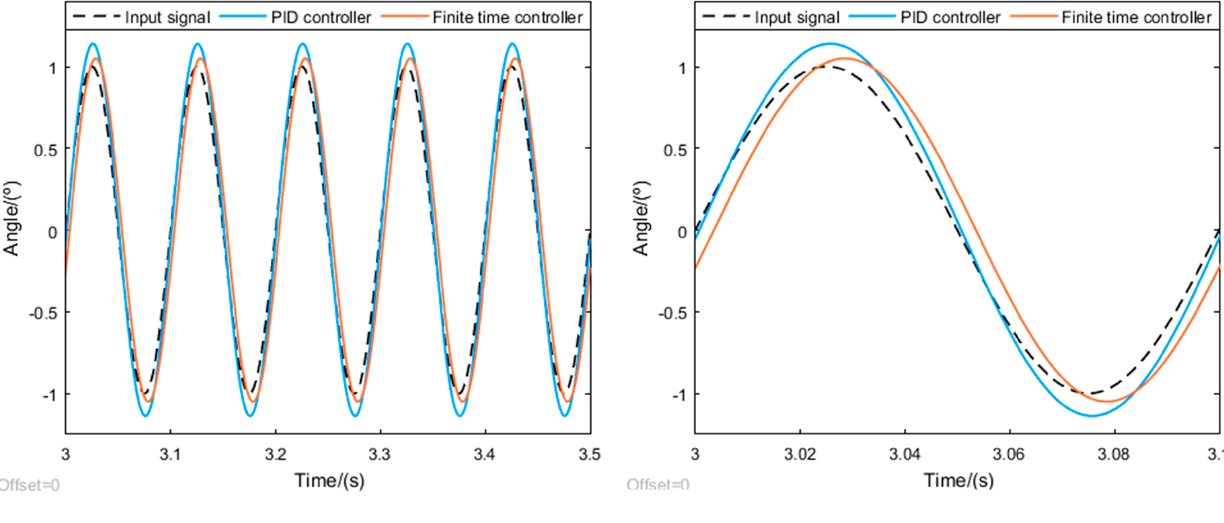
Figure 9. Finite-time composite control response curve of the motor system with 10 Hz and 1° sinusoidal signal.